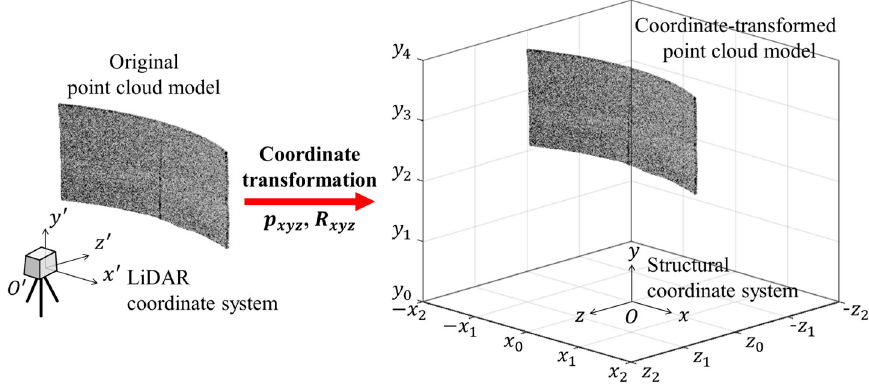
Figure 8. Coordinate transformation of the point cloud model.